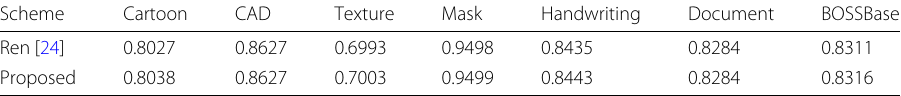
Table 3 Scrambling analysis with GDD measure for the proposed scheme and Ren’s scheme